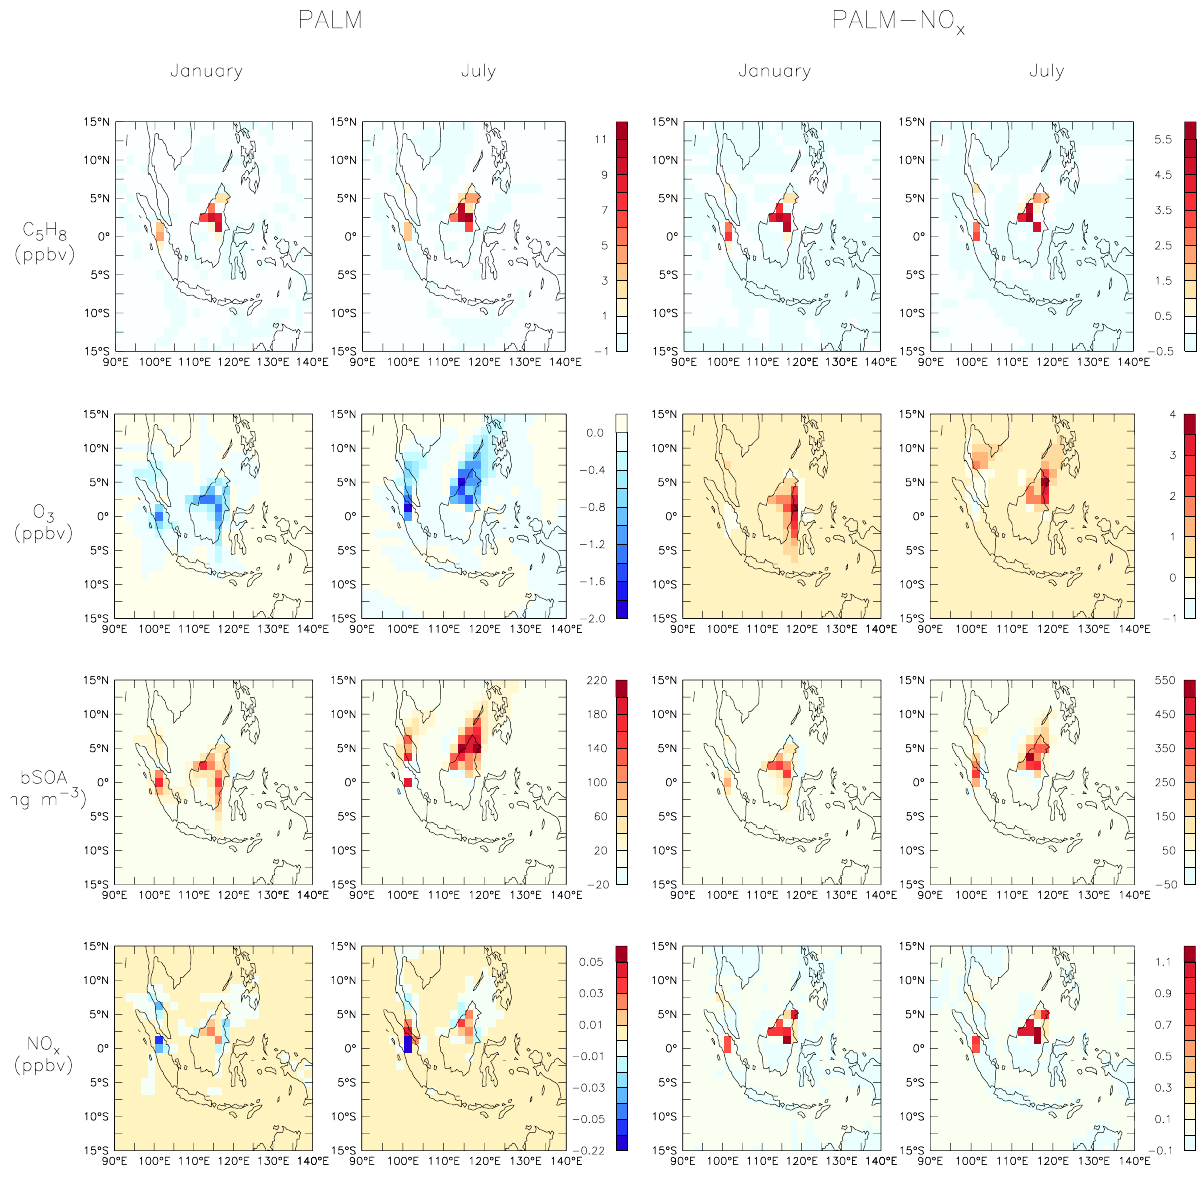
Fig. 1. Differences in monthly mean surface concentrations over SE Asia for PALM vs. CTRL (first two columns) and PALM NO x vs. CTRL (last two columns). The first column for each scenario shows monthly mean differences for January and the second shows July. The first row shows differences in isoprene, the second ozone, the third bSOA and the final row NO x . Note the scales for PALM and PALM NO x differ.